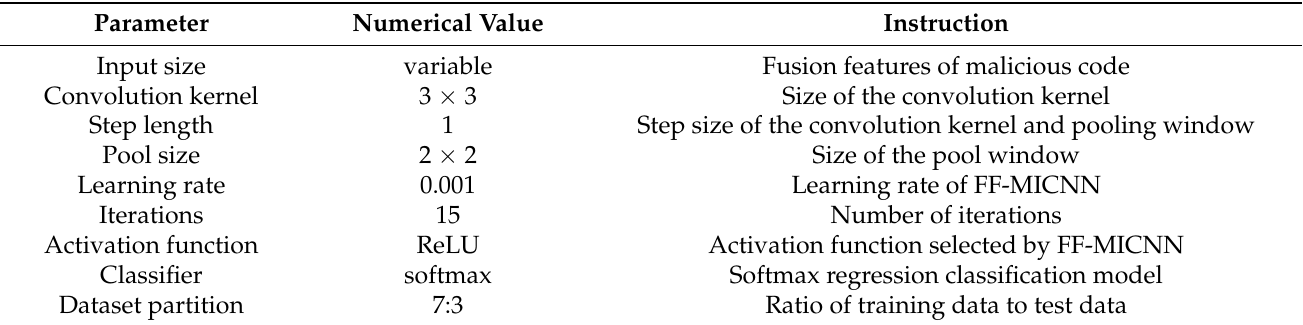
Table 6. The parameter setting of the model network.